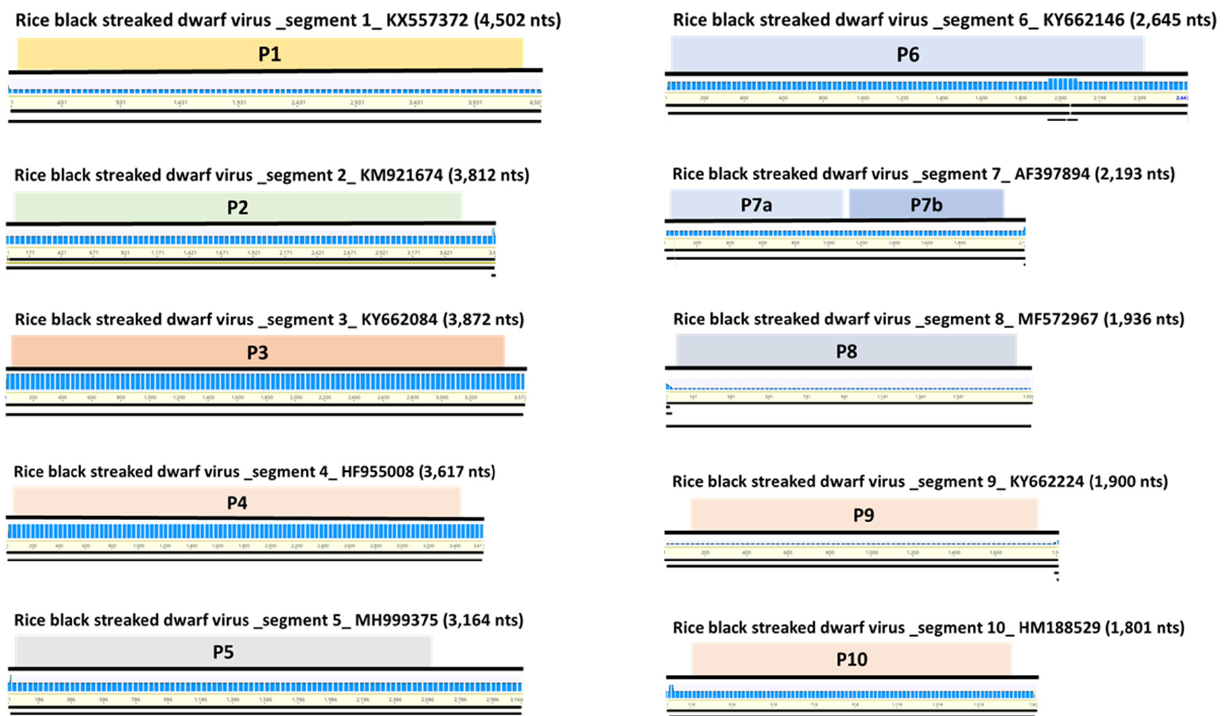
Figure 5. Genome assembly of identified RBSDV. Genome organization of each segment of identi- fied RBSDV isolate from YP. Table 3. List of identified viruses in six libraries in Korea.